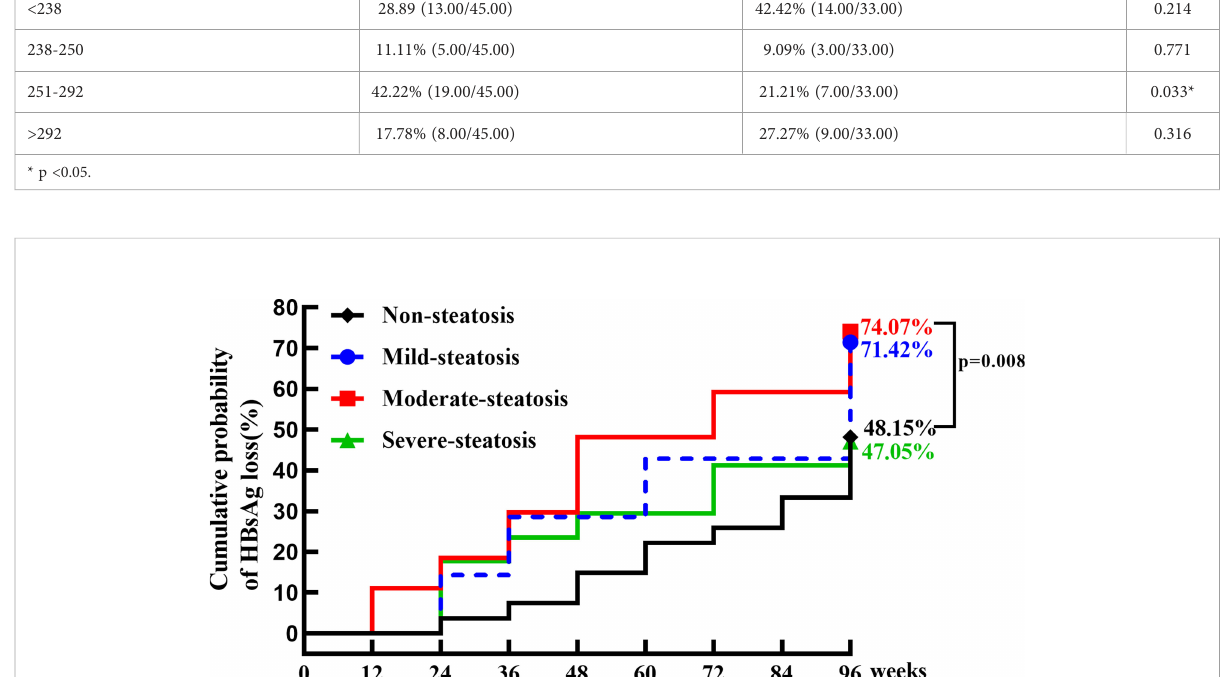
FIGURE 5 The cumulative incidence of HBsAg clearance in IHCs without and with hepatic steatosis (mild, moderate, severe). The cumulative incidence of HBsAg clearance was 48.15% (13/27), 71.42% (5/8), 74.07% (19/26) and 47.05% (8/17) in IHCs without and with mild, moderate, severe hepatic steatosis. The rate of HBsAg clearance was signi fi cantly higher in IHCs with moderate hepatic steatosis than in IHCs without hepatic steatosis (74.07% vs 48.15%, p =